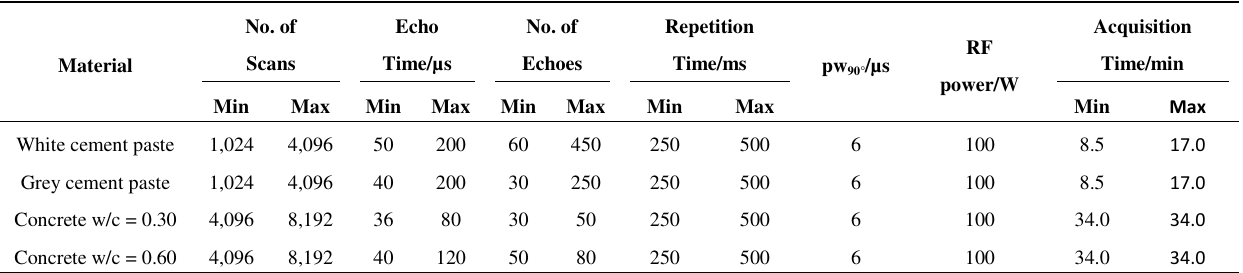
Table 2. CPMG parameters used for the measurements in cement pastes and concretes. Material White cement